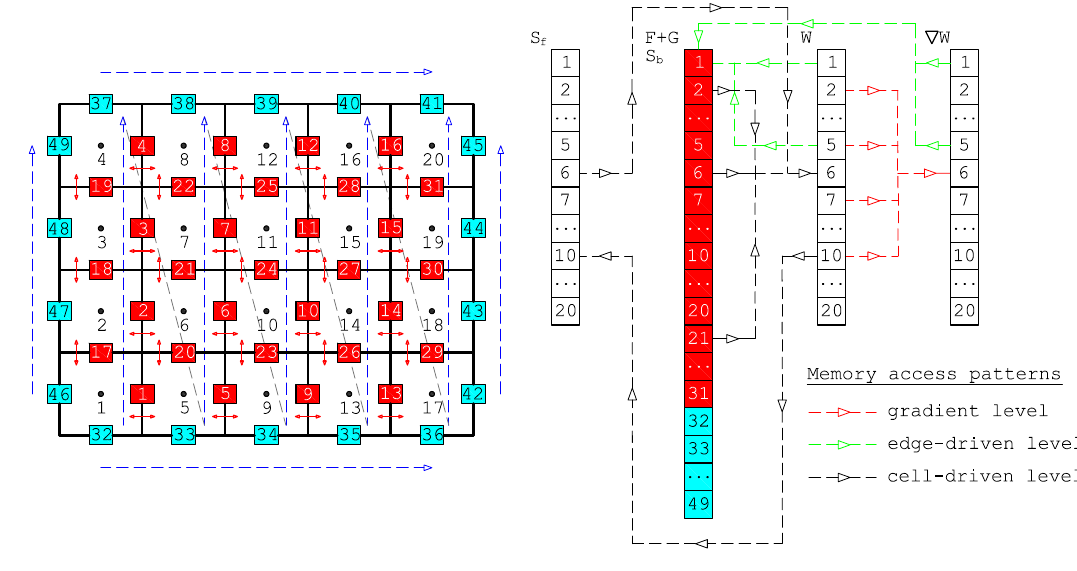
Figure 3. Cell-edge reordering strategy [21] and an example of memory access